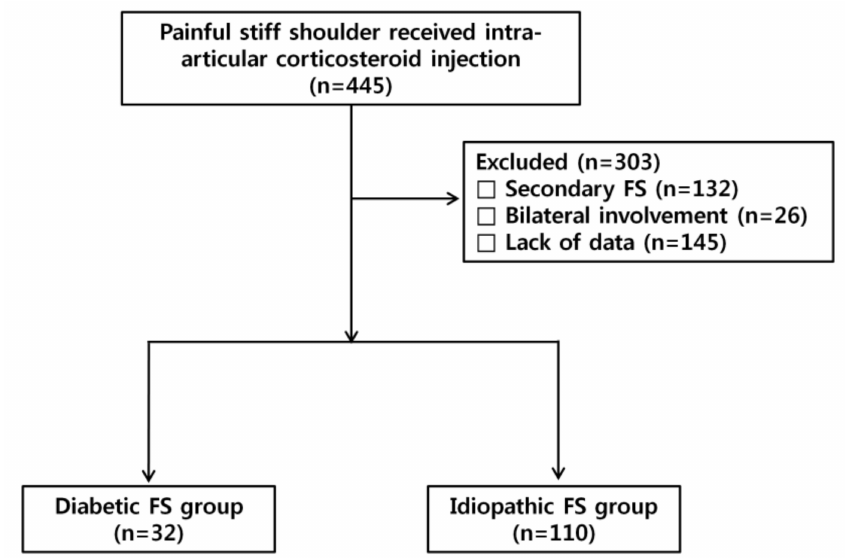
Figure 1. Flowchart illustrating patient selection and the number of